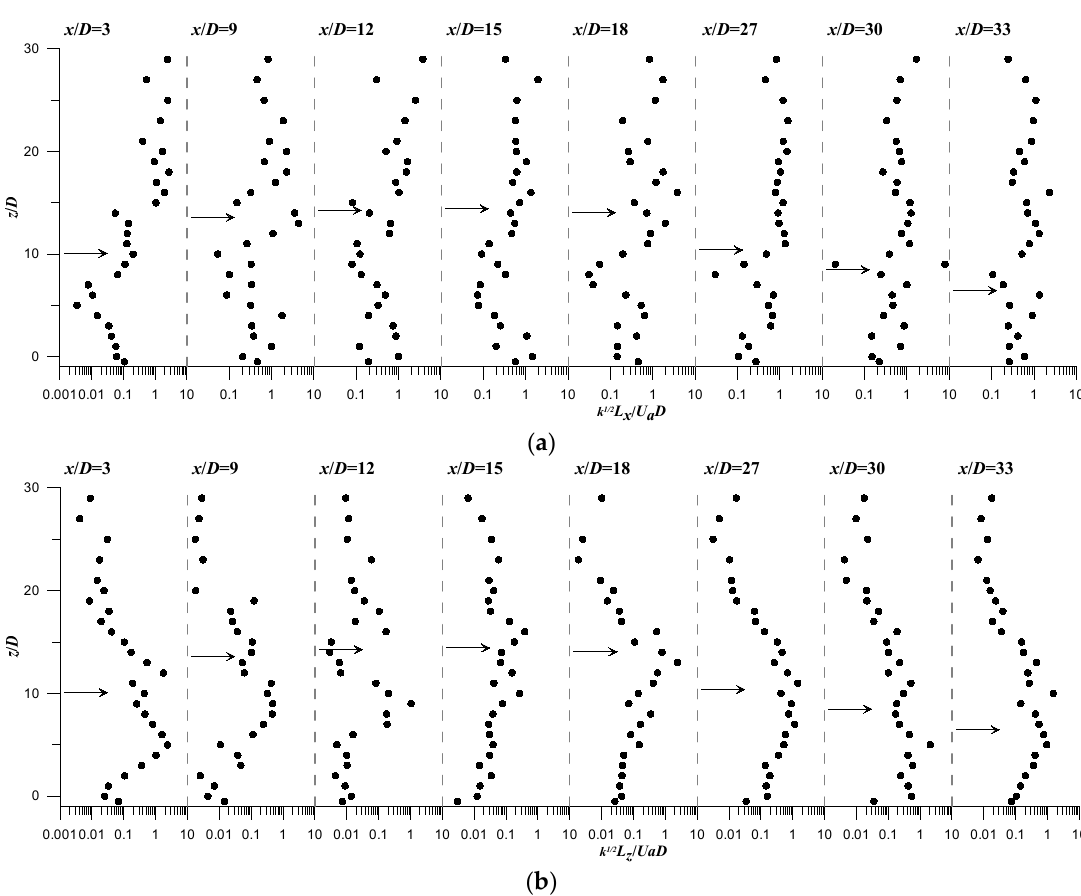
Figure 15. Trend of the turbulent dispersion coefficient K x and K z at different downstream positions x / D at the plane of flow symmetry ( y = 0) of run R1: ( a ) k x ~ k ½ L x / U a D ; ( b ) k z ~ k ½ L z / U a D . The horizontal arrow on the profiles indicate the position of the jet axis.